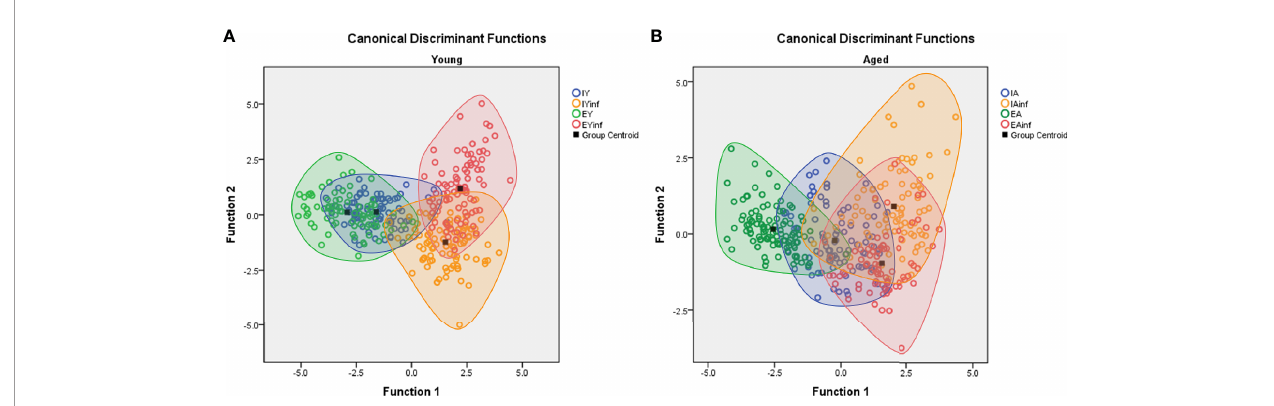
FIGURE 7 | Discriminant function analysis to illustrate age and environmental in fl uences on microglial morphological response in a mouse model of sublethal encephalitis induced with Piry arbovirus. Note that in young mice (A) there is a distinct distribution of microglia of infected (red and orange color open circles) in the right superior and inferior quadrants respectively, while in controls, the green and blue color open circles are in the central area of left quadrant. In contrast, the microglia of aged mice (B) , show larger areas of intersection between infected and control mice, indicating smaller in fl uence of environment on microglia morphological response. Orange and red circles represent infected mice; Green and blue circles indicate control mice. IY, young mice raised in impoverished environment; EY, young mice raised in enriched environment; IA, aged mice raised in impoverished environment; EA, aged mice raised in enriched environment; IYinf, infected young mice raised in impoverished environment; EYinf, infected young mice raised in enriched environment; IAinf, infected aged mice raised in impoverished environment; EAinf, infected aged mice raised in enriched environment. Square black dot = ellipsoid center of each experimental